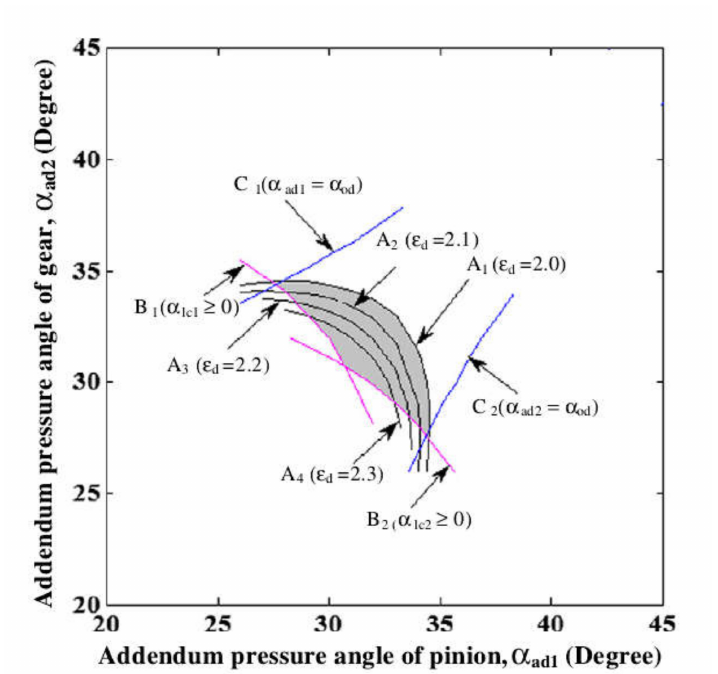
Figure 3. Area of existence diagram for constant drive-side contact